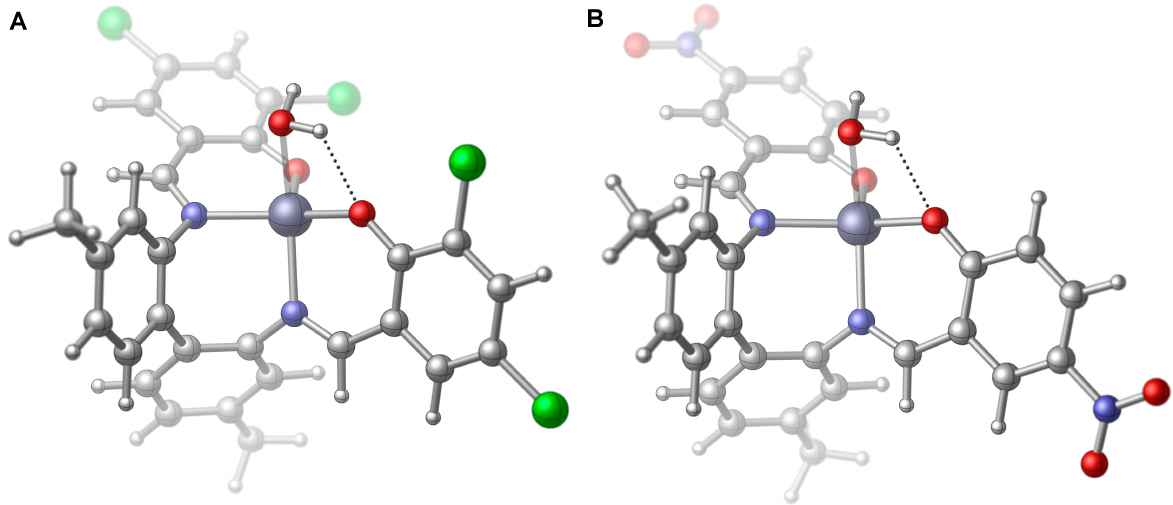
Figure 5. The optimized ground-state geometries of Z1Zn ( A ) and Z2Zn ( B ) complexes at the B3LYP/6-31G(d) level of theory. (O: red, N: blue, C: gray, and Cl: green). Dotted line for O–H···O hydrogen bonding.